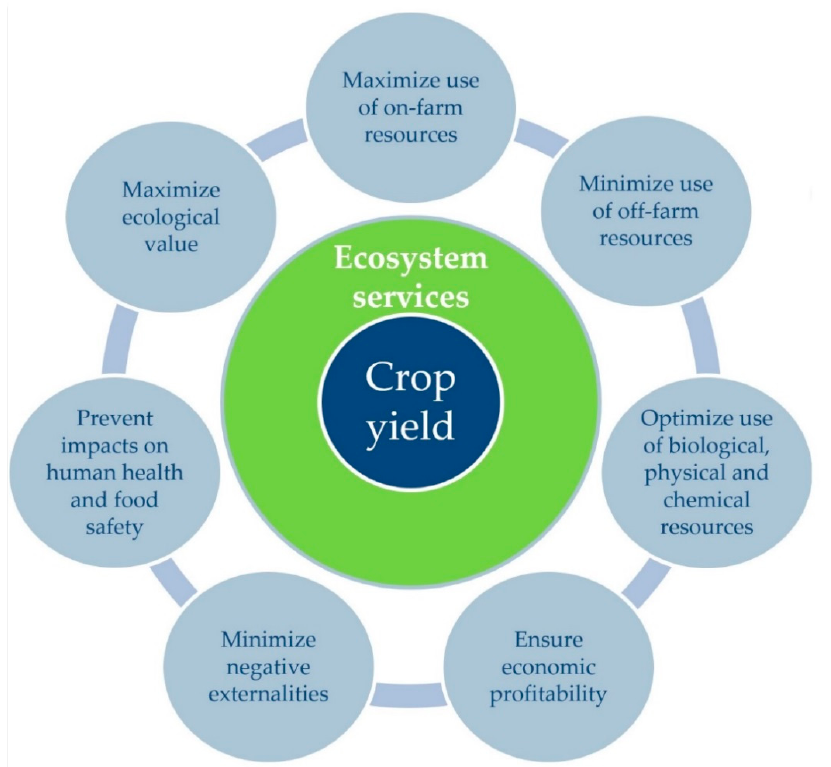
Figure 1. Principles of low-input agriculture (Source: This study).